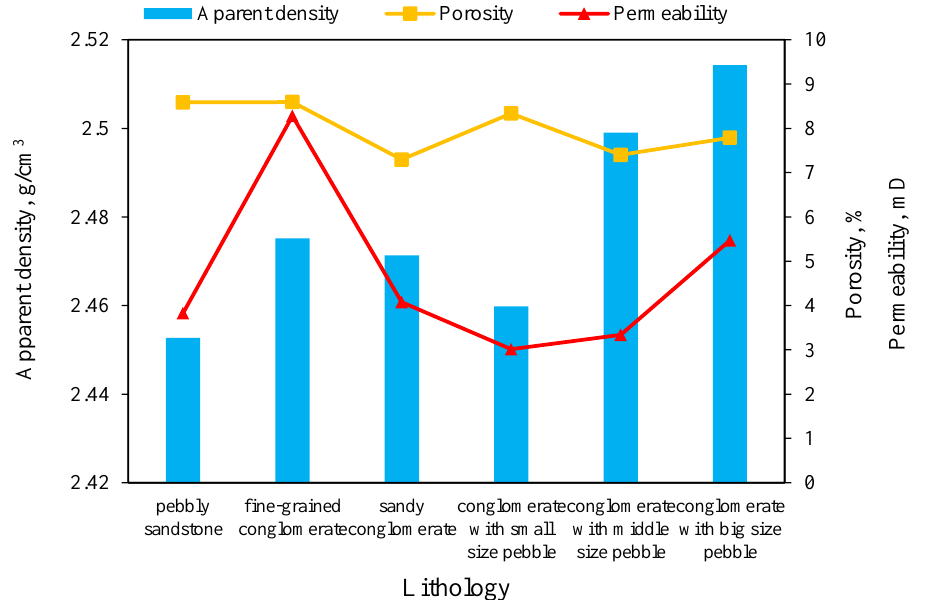
Figure 8. Porosity, permeability, and apparent density of the different lithologies in the Mahu area.